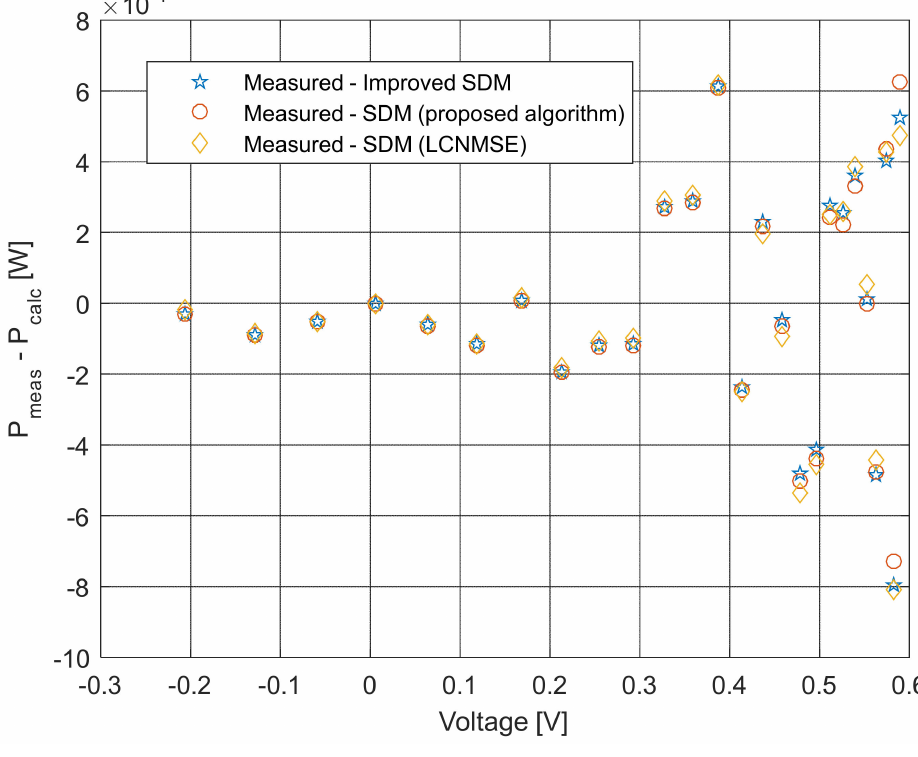
Figure 13. Difference between the measured and calculated power values using different methods for both SDM and